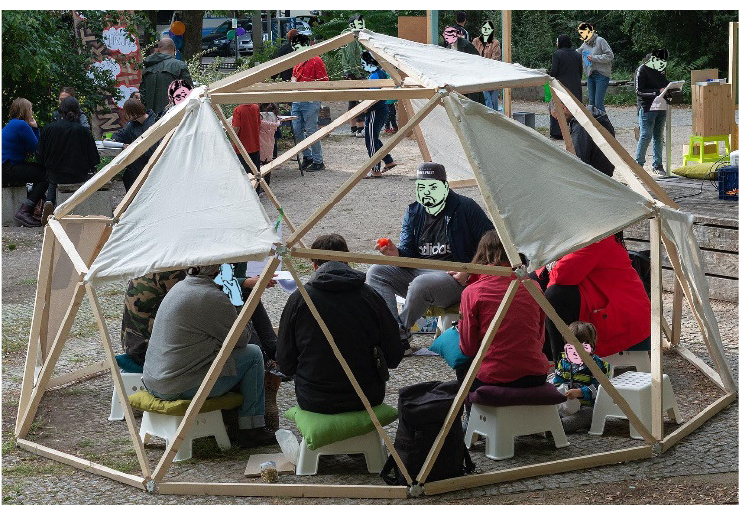
Figure 2. Story‐circle. Photograph by Michael Shenbrot and illustrations by Zeynep Keskin. Source: Courtesy of ©